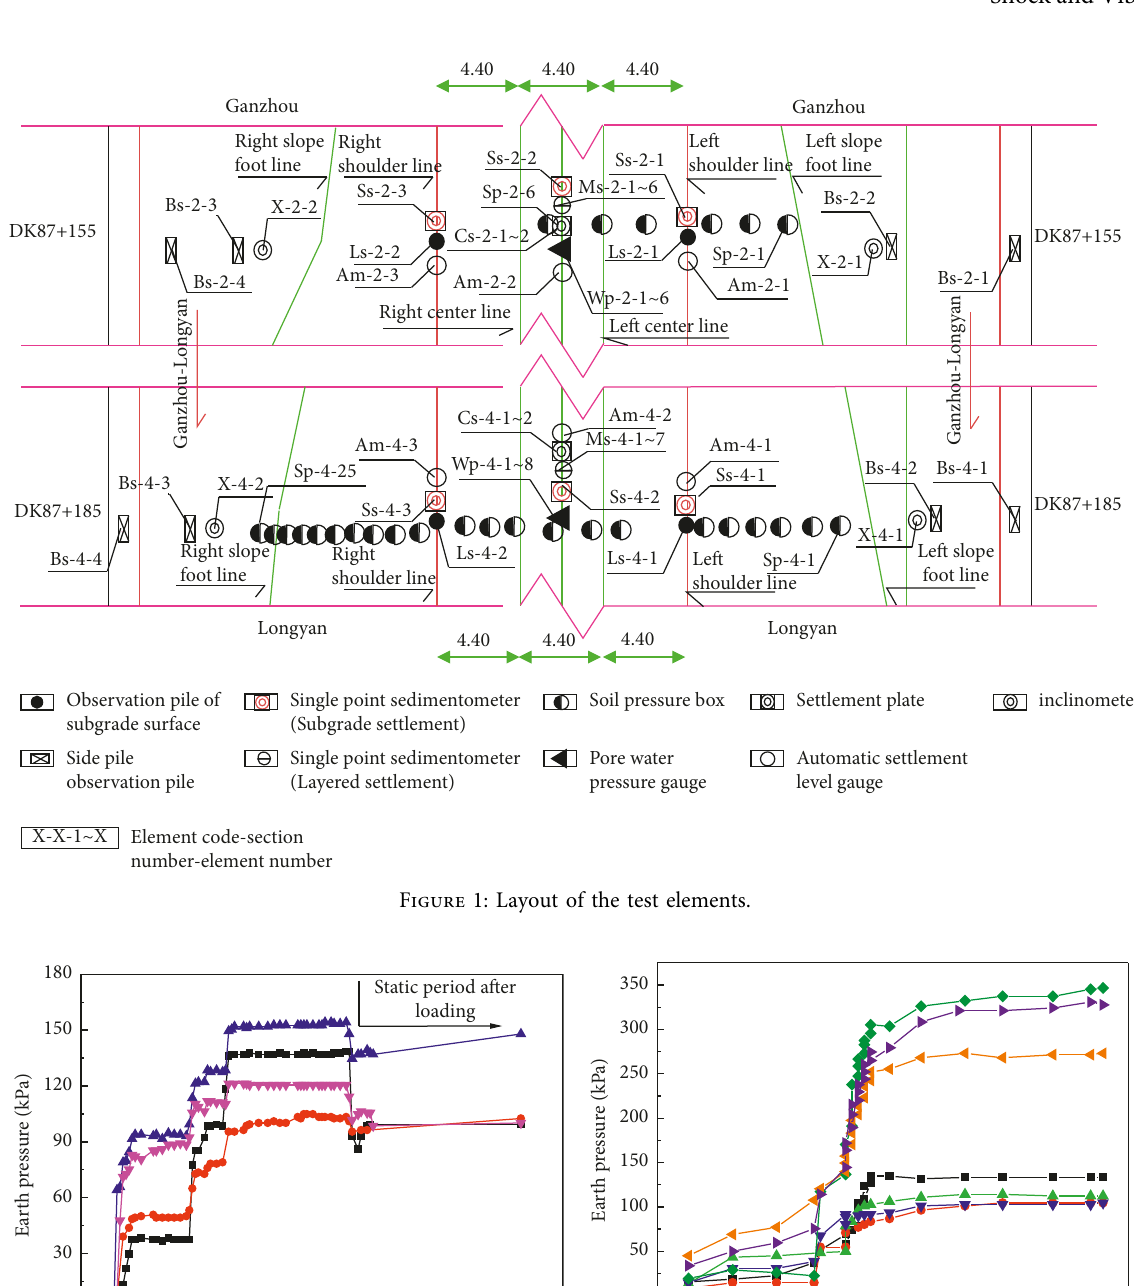
Figure 2: Curve of Earth pressure-time-load: (a) natural foundation (DK87+155 section); (b) composite foundation (DK87 +185